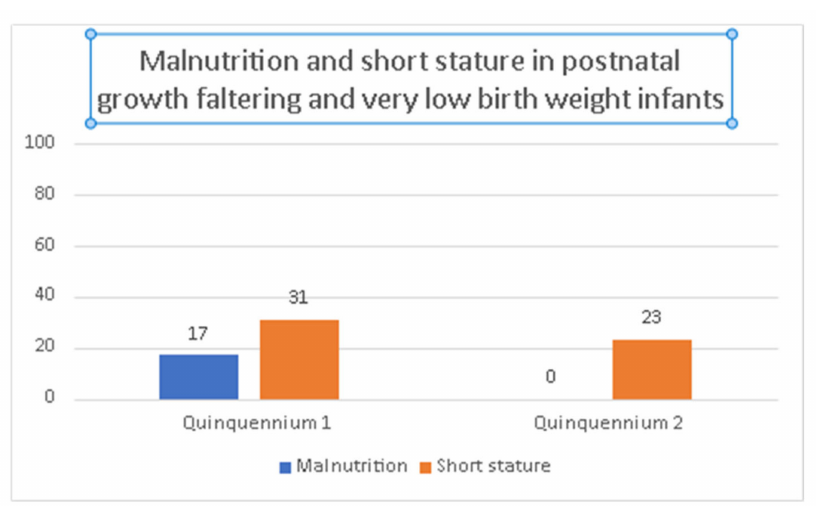
Figure 6. Prevalence of malnutrition and short stature at 2 years (quinquennium 1: 2002–2006 vs. quinquennium 2: 2013–2017) in postnatal growth faltering (PGF) and very low birth weight